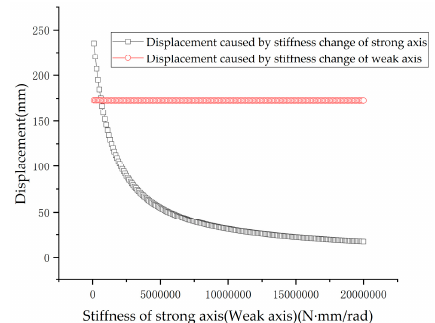
Figure 12. Sensitivity curve of C M plate thickness.